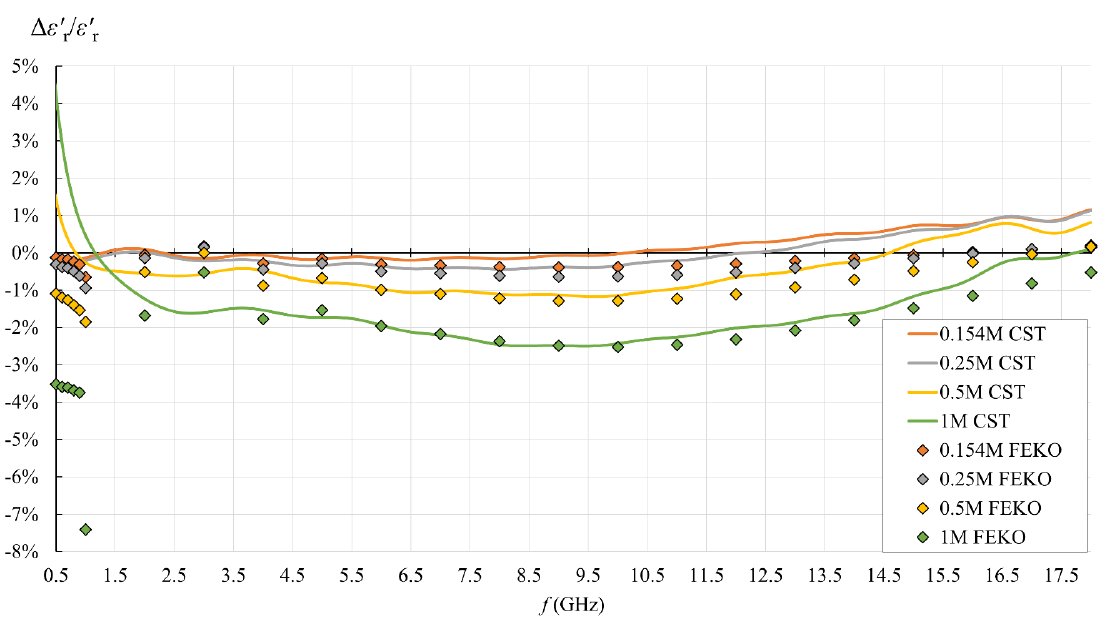
Figure 15. 𝜀 r′ relative error of the simple capacitive-load model (FEKO: discrete points; CST: solid lines) with respect to the set 𝜀 r′ value .